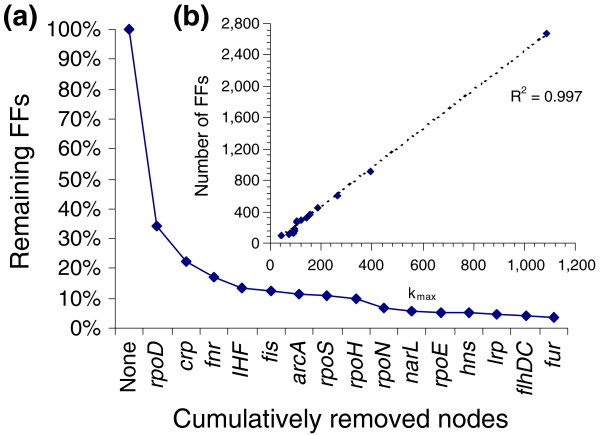
FFs bridge modules and shape the backbone of the hierarchy governing the TRN. (a) Remaining TFs after cumulative removal of hierarchical nodes. The removal of all hierarchical nodes decreased to 3.5% the total FFs. (b) Correlation between FF number and maximum connectivity for each attacked network. The FF number is proportional to the number of links of the most-connected hierarchical node, thus suggesting that FFs are the backbone of the hierarchy in the TRN.